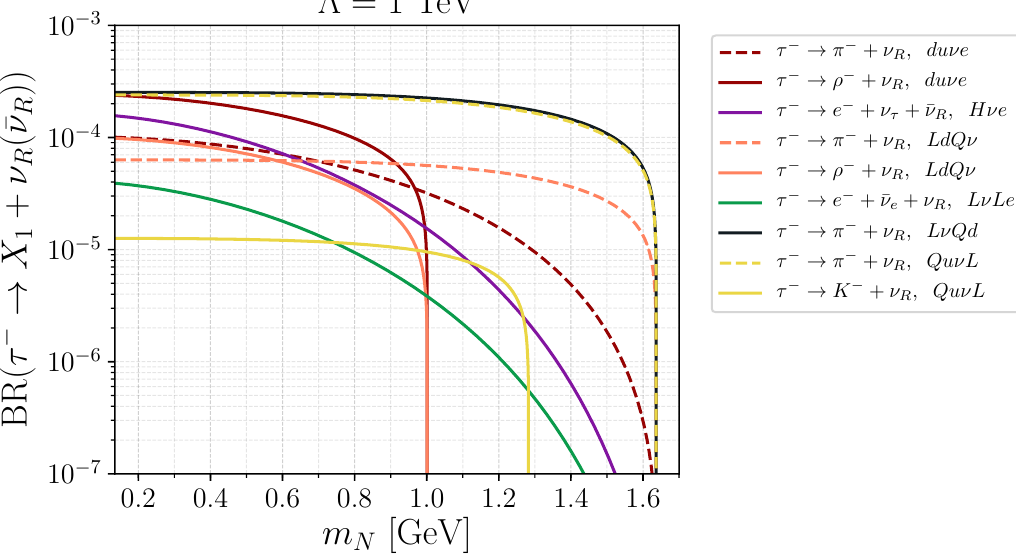
Figure 4 . Tau decay branching ratios into a sterile neutrino for Λ = 1 TeV.